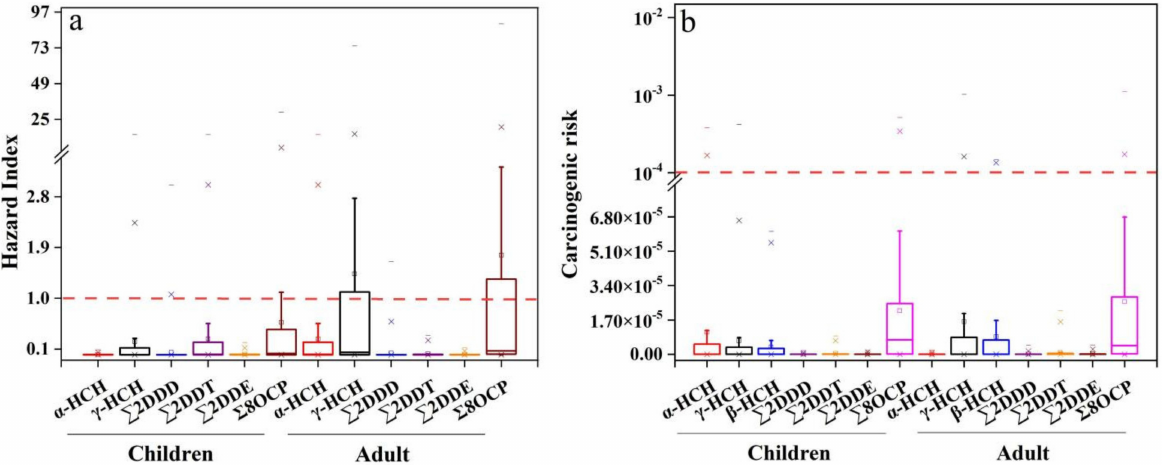
Figure 3. ( a ) Non-carcinogenic risks and ( b ) carcinogenic risks to children and adults through dietary and non-dietary exposure pathways to